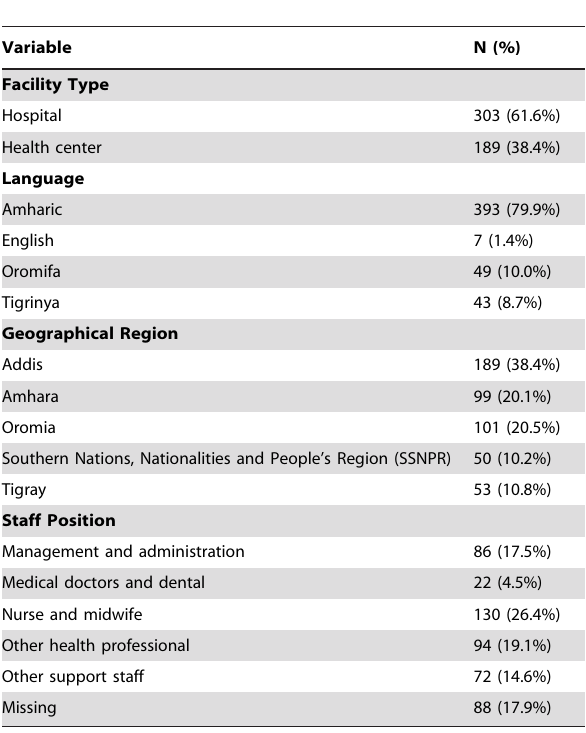
Table 1. Demographic characteristics for